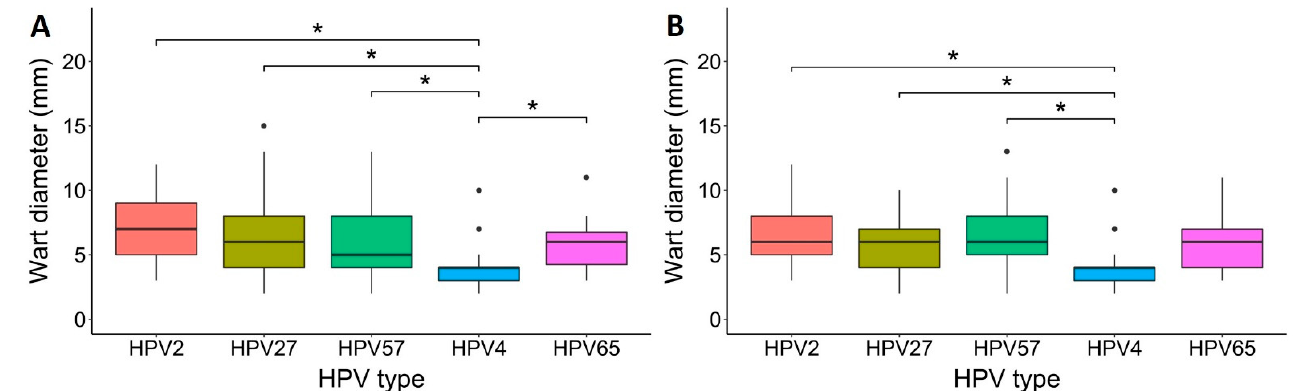
Figure 5. The size of common warts caused by the five most frequent causative human papillomavirus (HPV) types. ( A ) Comparison of the size of common warts at different anatomical sites among the causative HPV types. HPV4 caused significantly smaller common warts (median diameter: 4 mm) than HPV2 (median diameter: 7 mm; *, p = 0.021), HPV27 (median diameter: 6 mm; *, p = 0.030), HPV57 (median diameter: 5 mm; *, p = 0.041), and HPV65 (median diameter: 6 mm; *, p = 0.041). ( B ) Comparison of the size of common warts on the hands among causative HPV types. HPV4 caused significantly smaller common warts (median diameter: 4 mm) than HPV2 (median diameter: 6 mm; *, p = 0.017), HPV27 (median diameter: 6 mm; *, p = 0.056), and HPV57 (median diameter: 6 mm; *, p = 0.017). Both statistical comparisons were performed with the Kruskal–Wallis test.